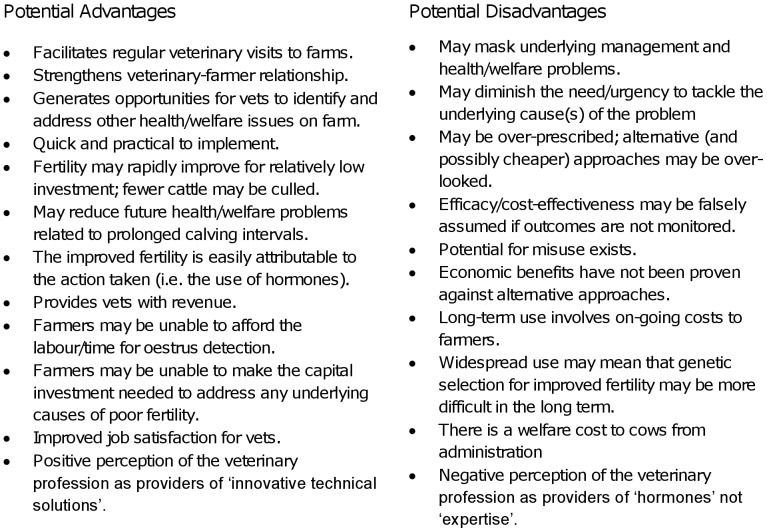
Potential advantages/disadvantages of prescribing hormones from a veterinary perspective.The context relates to the use of hormones to assist breeding in lactating dairy cattle without reproductive pathology. The lists provide a summary of interviews with three veterinary academics and two veterinary practitioners. There is no significance attached to the vertical order of items.